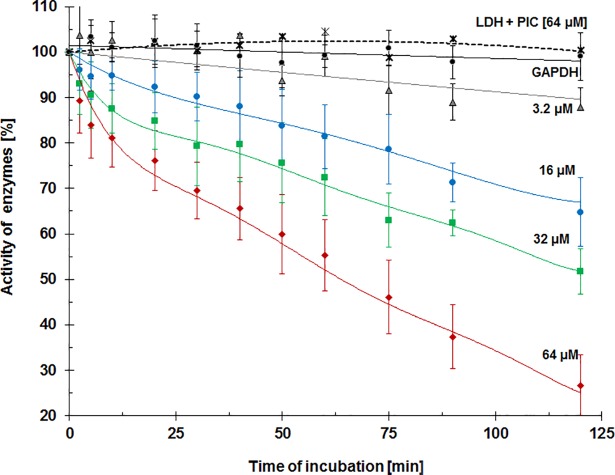
The effect of piceatannol on the activity of GAPDH, measured during 2 hours of incubation of GAPDH (2 μM) with piceatannol at concentrations 0, 3.2, 16, 32 and 64 μM (continuous lines).Similarly, the effect of piceatannol at the concentration 64 μM on the activity of LDH was determined (black dashed line). Catalytic activity of enzymes are expressed as percentages referring to the activity of untreated samples (control). Data are means ± SD of n = 4–8 independent measurements.